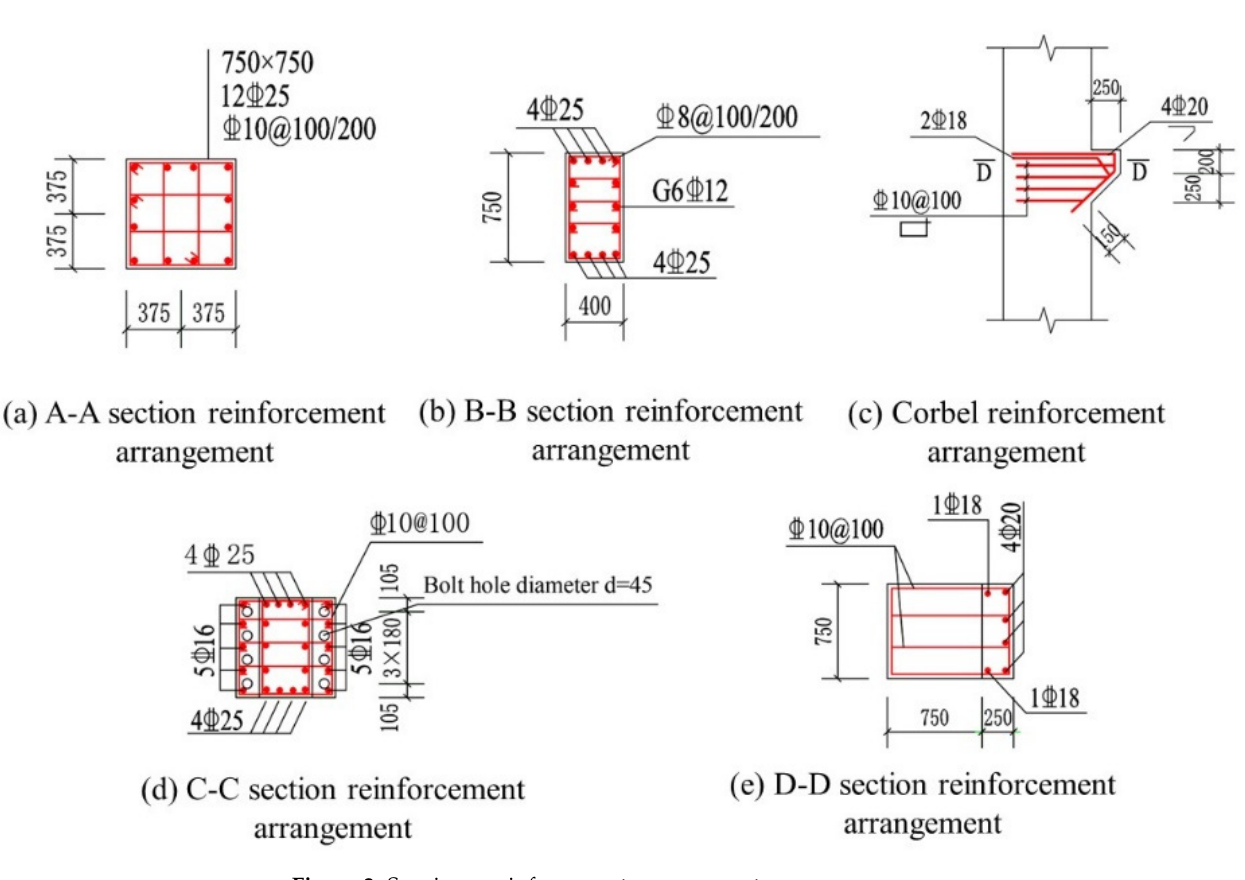
Figure 2. Specimen reinforcement arrangement.